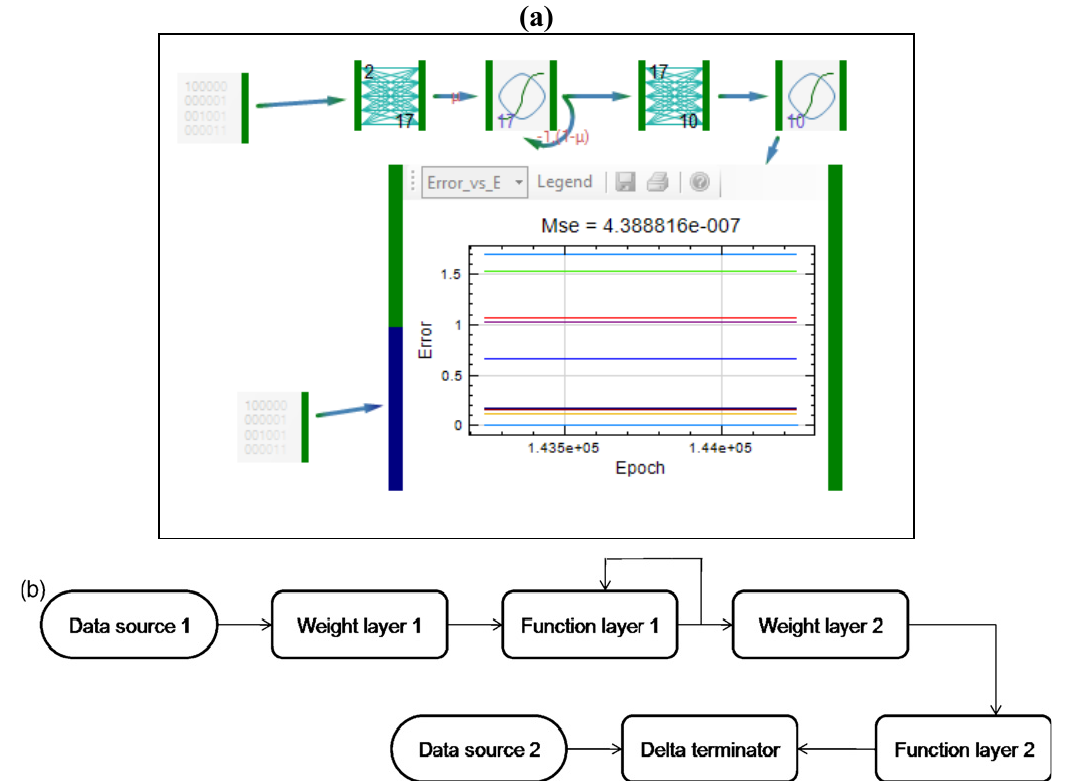
Figure 11. Representation of recurrent one layer dynamic neural network